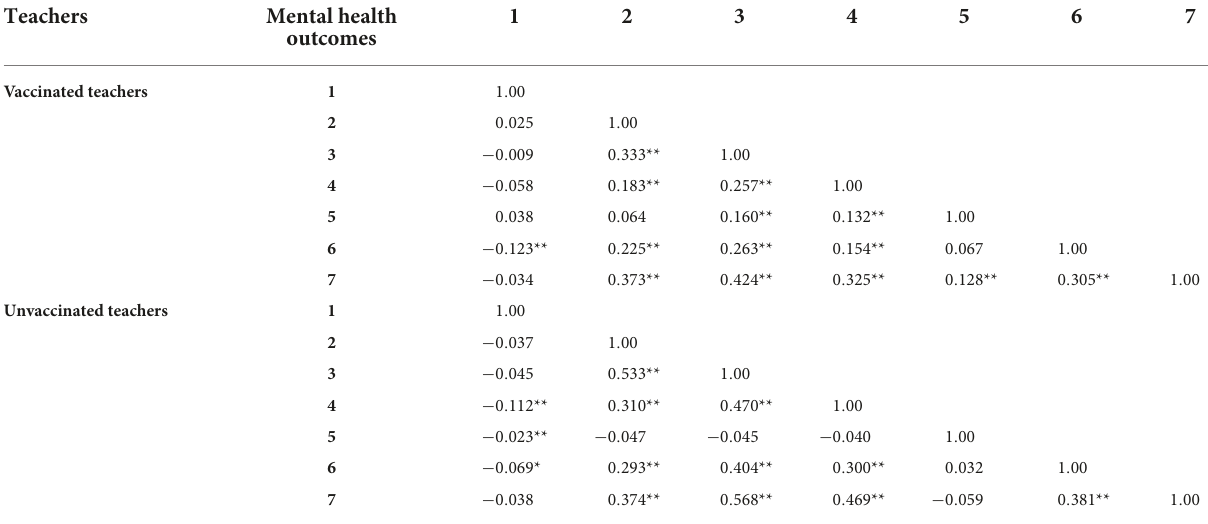
TABLE 3 Spearman’s correlations of mental health outcomes among vaccinated and unvaccinated teachers against COVID-19 infection. Teachers Mental health outcomes Vaccinated